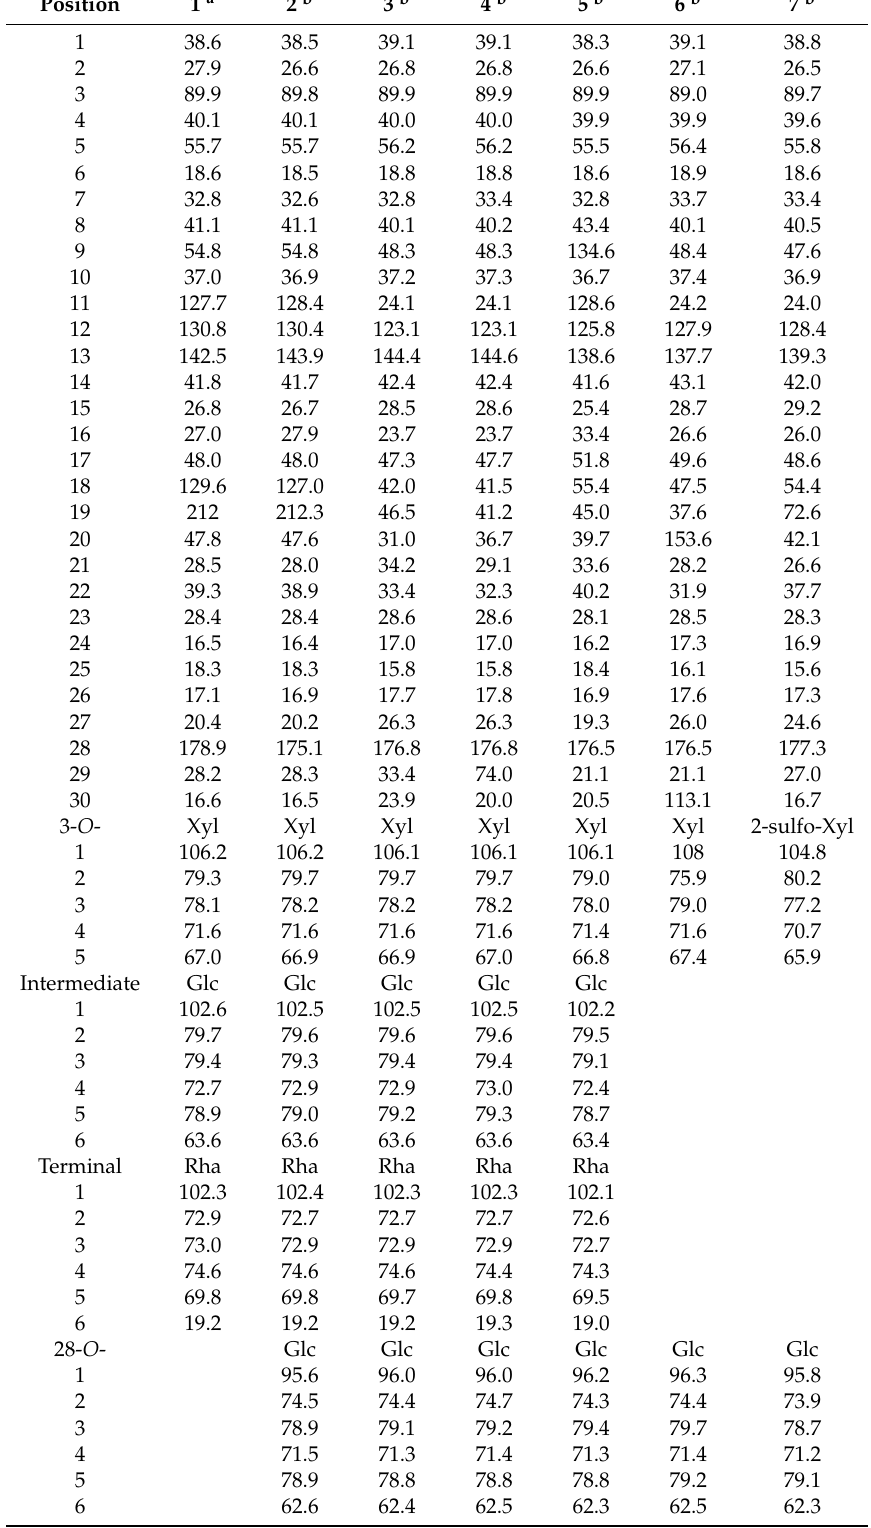
Table 2. 13 C NMR spectroscopic data of compounds 1 – 7 (in pyridine- d 5